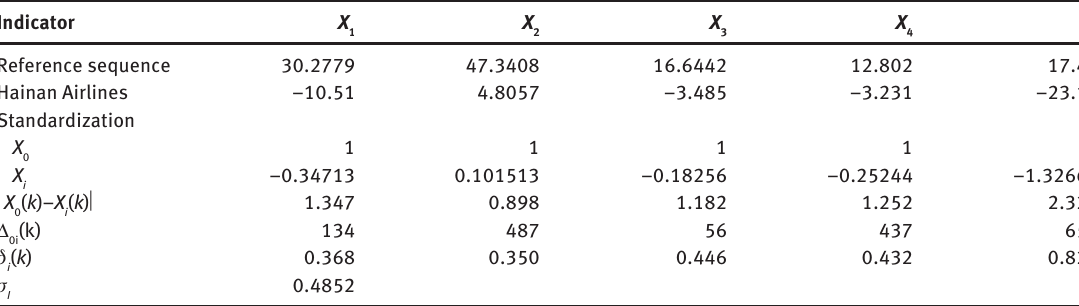
Table 3. Calculation of the Correlation Degree of Hainan